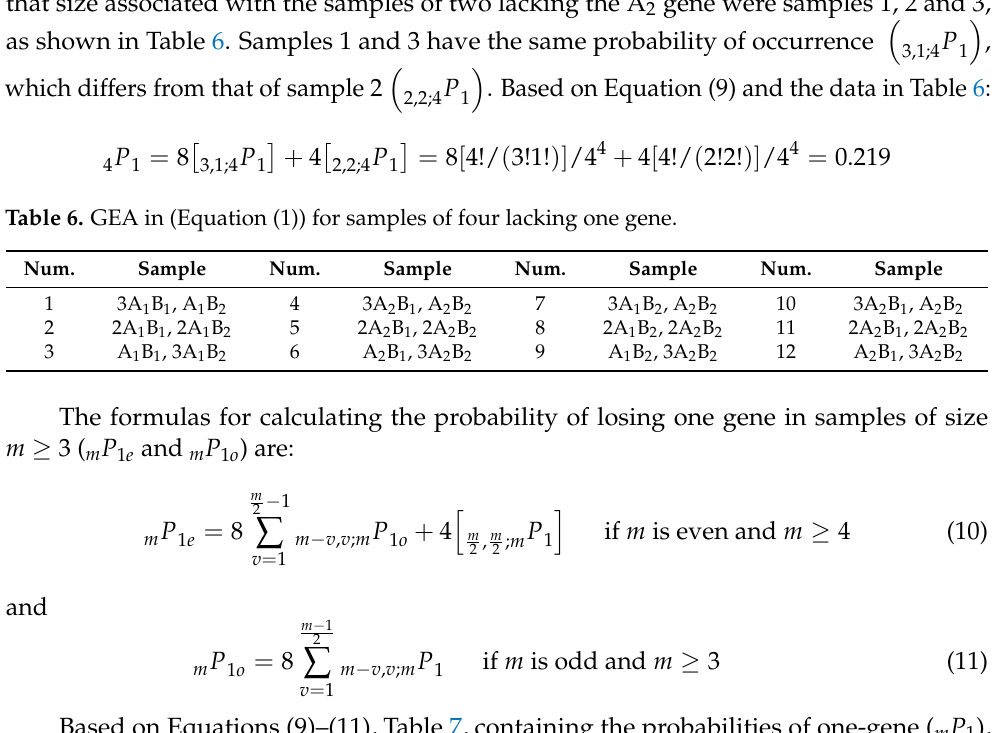
A 1 B 1 A 2 B 1